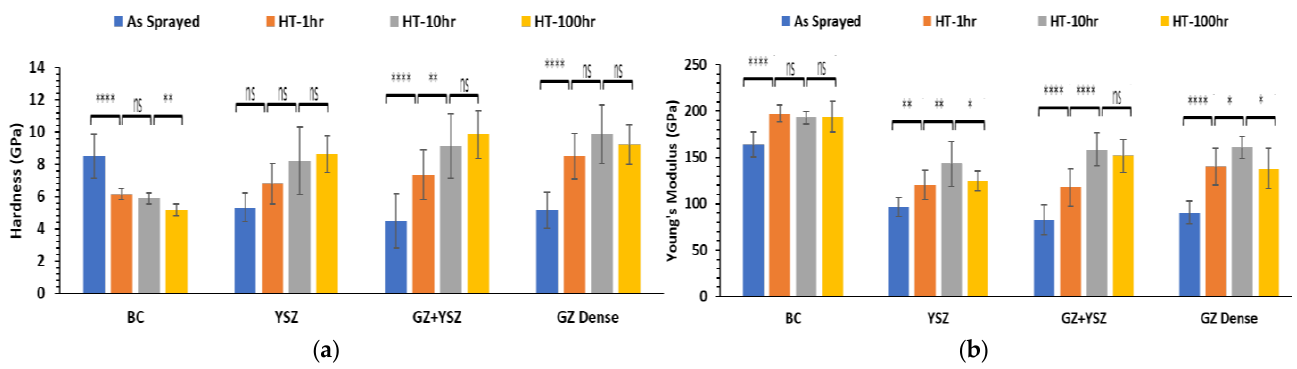
Figure 16. Nanoindentation data of the composite layer TBC before and after thermal treatment ( a ) hardness (H), ( b ) elastic modulus (E). Asterisks indicate a statistical difference (* p < 0.05, ** p < 0.01, *** p < 0.001, **** p < 0.0001, obtained using Tukey test, which computes a confidence interval for the difference between two means).